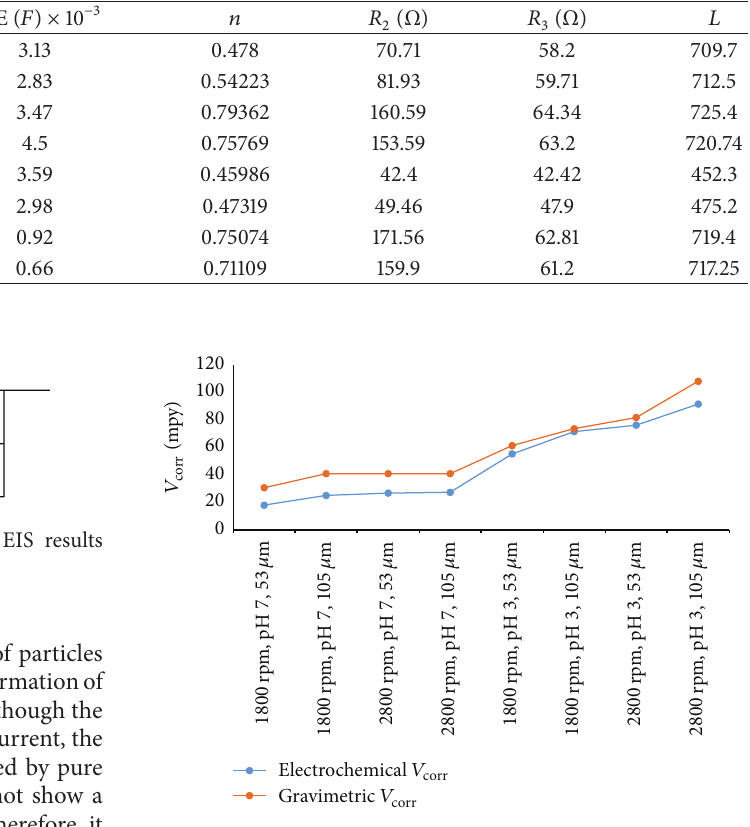
Table 1. An accelerated corrosion decreases charge